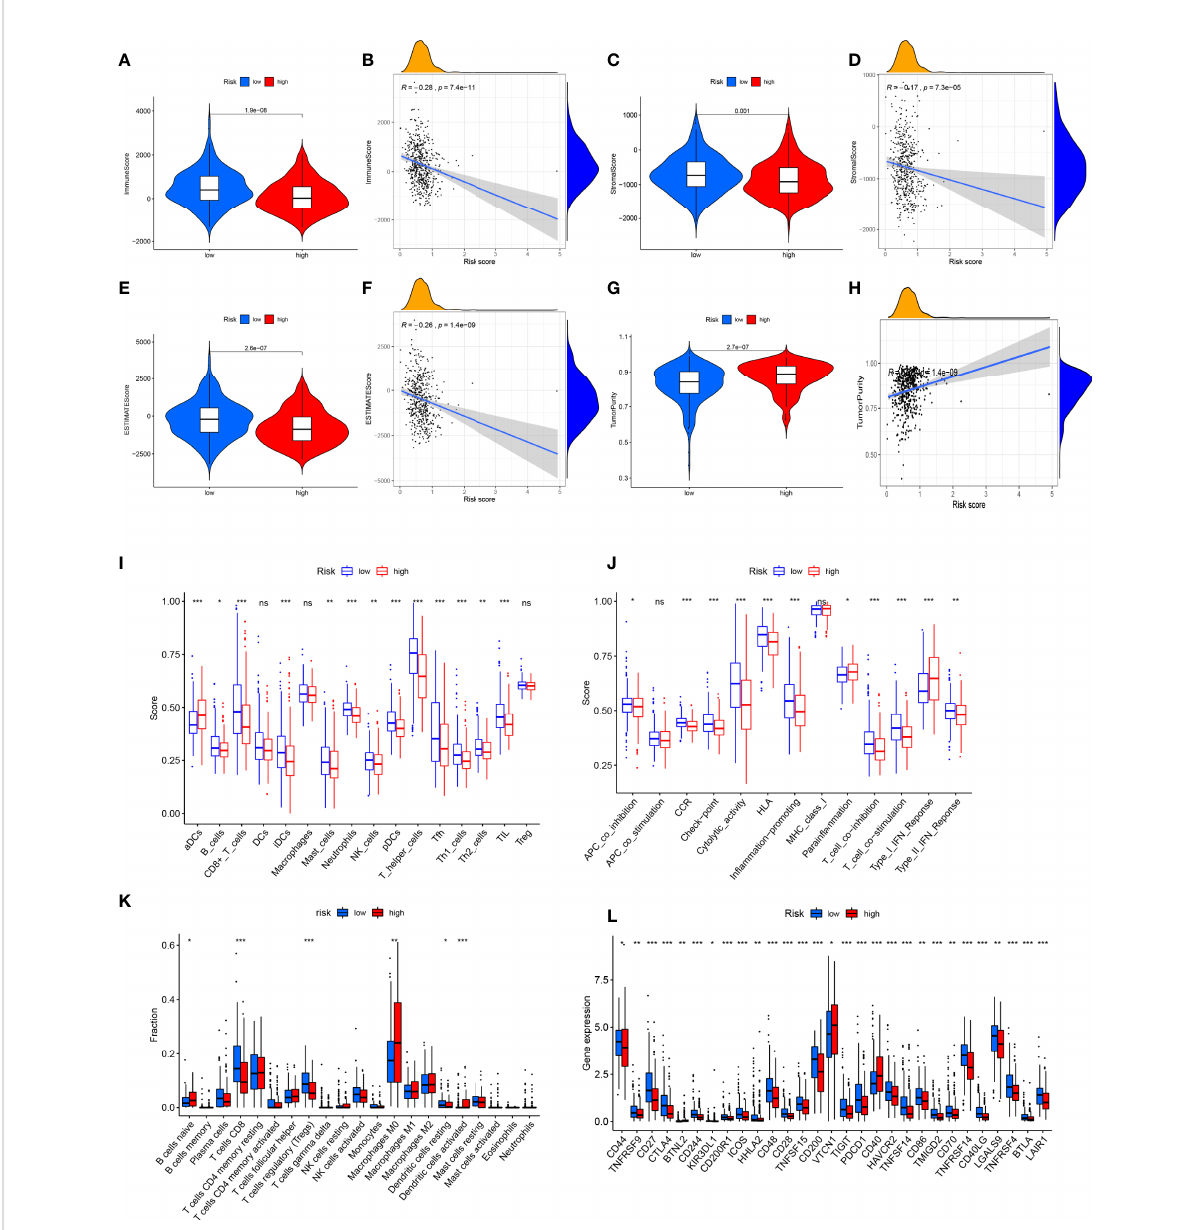
FIGURE 8 Analysis of immune microenvironment. (A, B) Immune score was lower in the high-risk group, and there was a signi fi cant negative correlation with risk scores. (C, D) Stromal score was lower in high-risk group, and there was a signi fi cant negative correlation with risk score. The (E, F) ESTIMATE score was lower in the high-risk group and signi fi cantly negatively correlated with the risk score. (G, H) Tumor purity was higher in the high-risk group, and there was a signi fi cant positive correlation with risk score. (I – K) Analysis of in fi ltration level of immune cells. (L) Expression analysis of immune checkpoint-related genes. *P<0.05, **P<0.01, ***P<0.001, ns, no signi fi